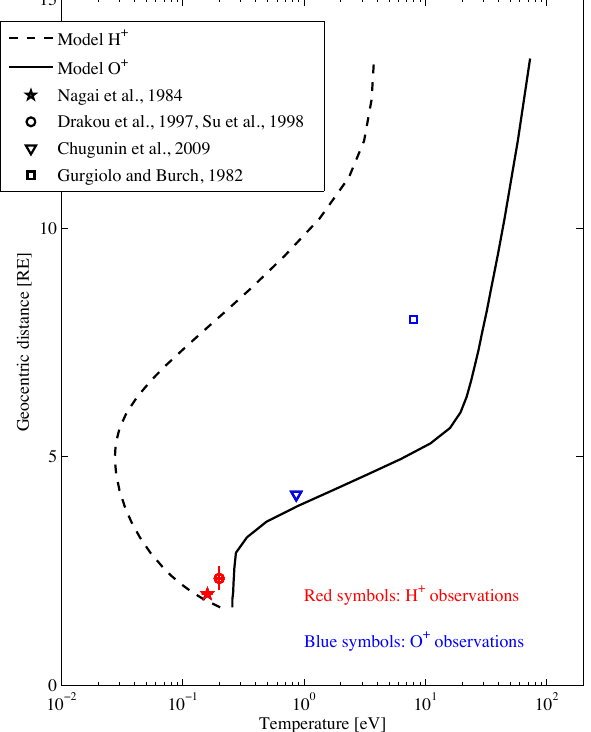
Fig. 7. Altitude profiles of ions temperatures, for O + ions (solid line) and H + ions (dashed line), when perpendicular wavelength of the electromagnetic turbulence λ ⊥ = 8km. Different corresponding observations are marked on the profiles.